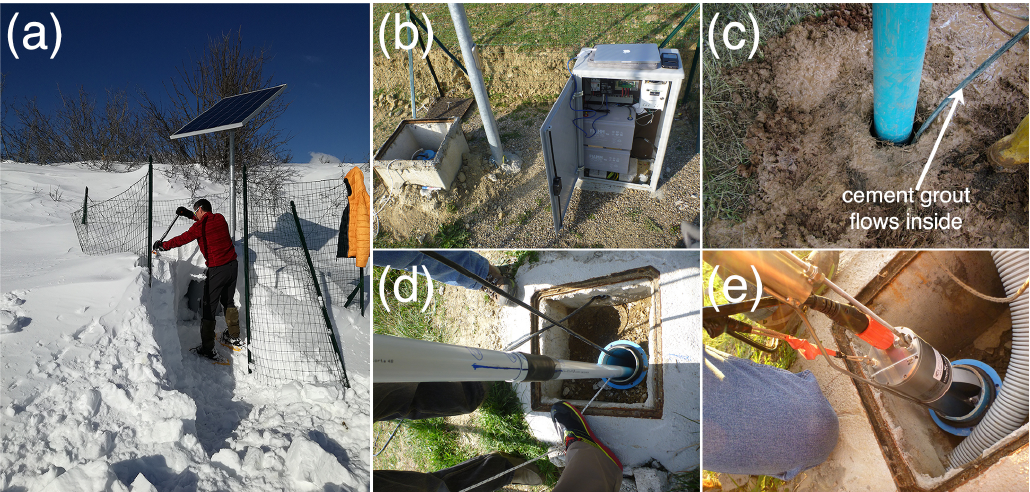
Figure 3. Details of a typical seismic station of the INSIEME network: (a) the solar panel is installed on a pole of 2m height in order to prevent it being covered by snow during the winter season; (b) all the instruments of a station are housed in a small cabin which is connected to the borehole where the seismometer is installed inside a PVC casing; (c) the PVC casing is coupled to the soil using cement grout; (d) the PVC casing is not centred in order to leave space for installing sensors on the surface, and seismometers placed at 6m depth are installed by using a non-rotating pipe system; (e) all the broadband seismometers installed in boreholes are equipped with a coupling